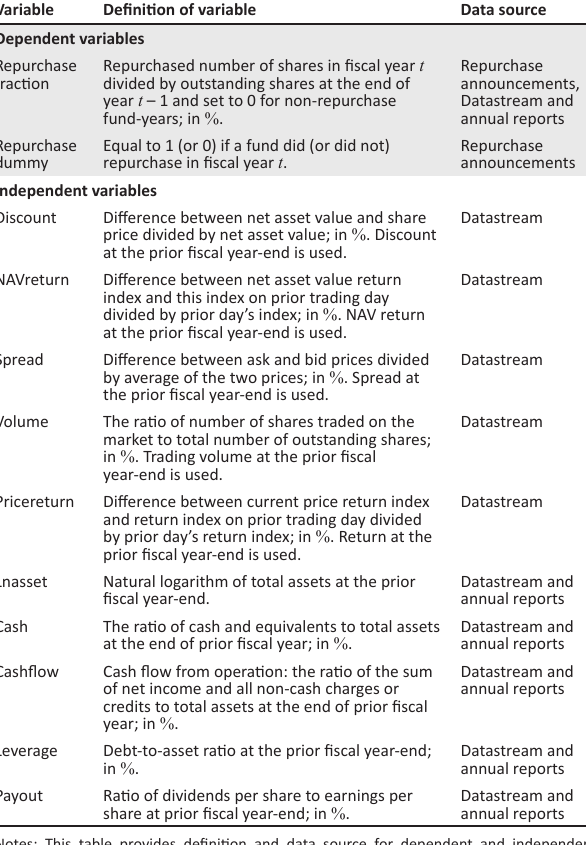
TABLE 3: Definitions of all